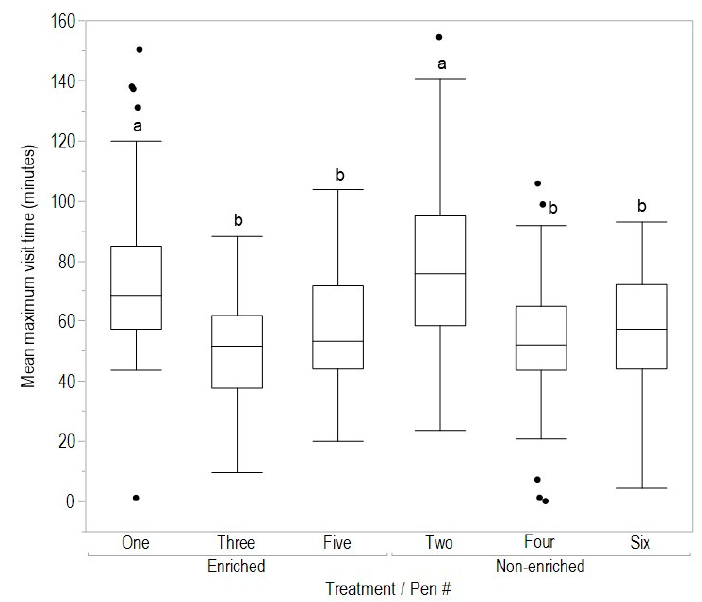
Figure 5. The mean maximum visit time (minutes) outdoors by hens in each pen within the early rearing treatments (enriched, non-enriched). Data were from 36 to 38 weeks of age; dissimilar letters indicate differences between pens within treatments ( p < 0.008).